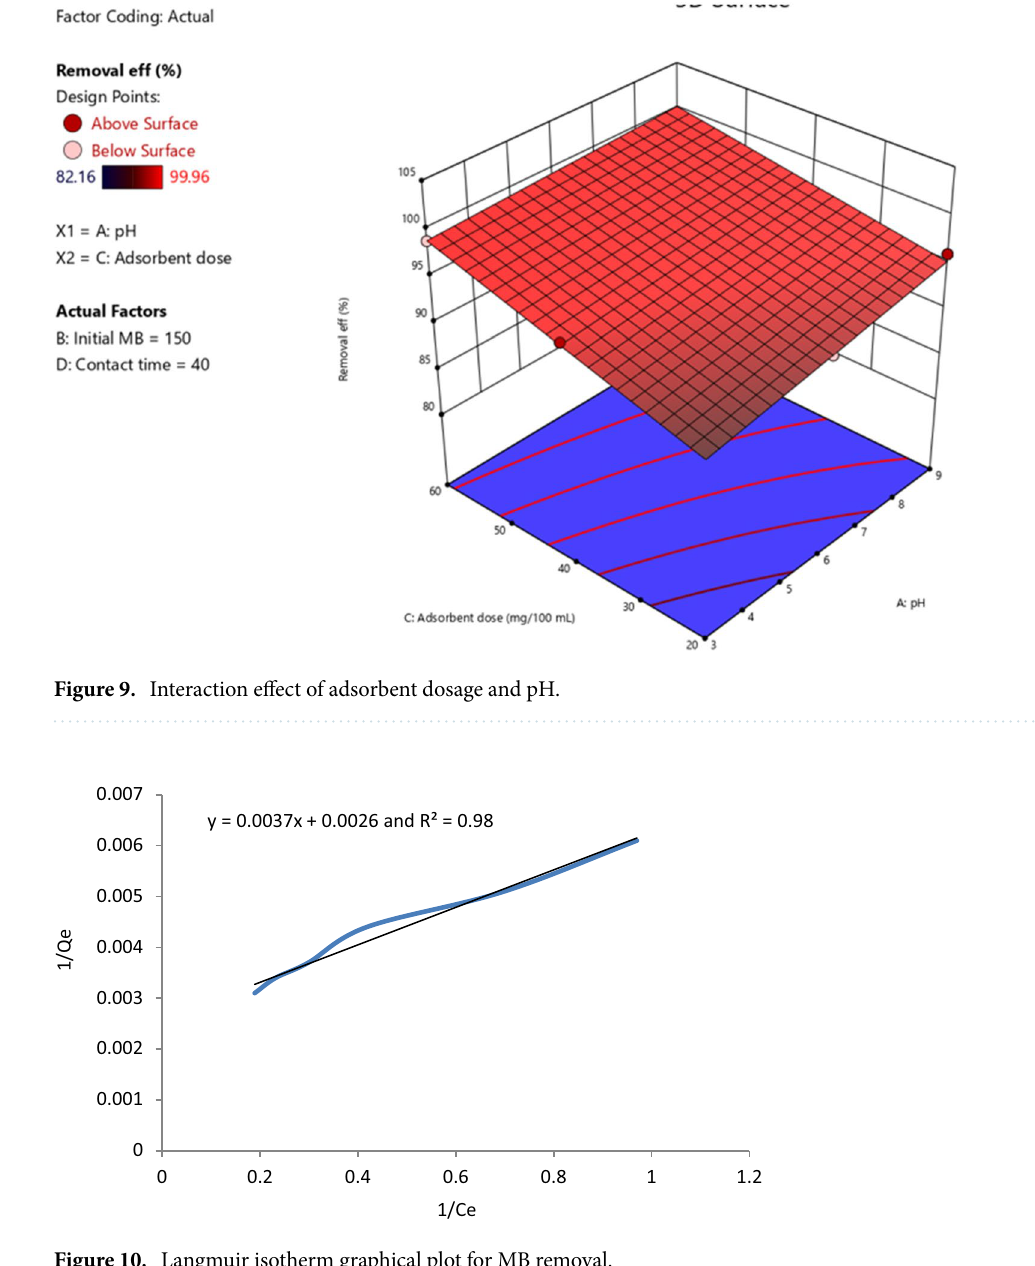
Figure 10. Langmuir isotherm graphical plot for MB